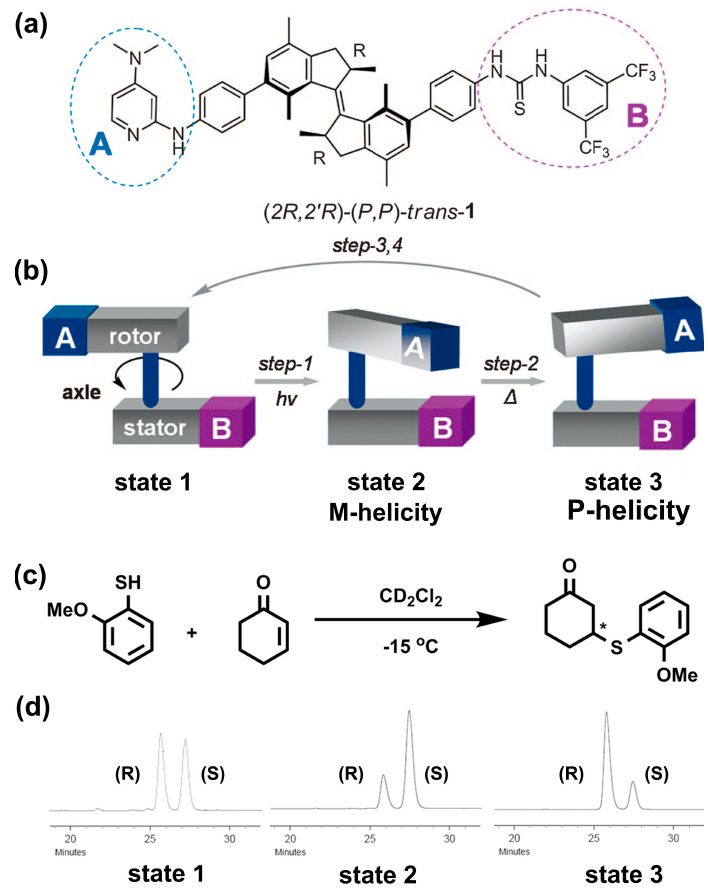
Figure 3. ( a ) Chemical structure of light-driven molecular motor; ( b ) Schematic illustration of one full rotary cycle by photo and thermally stimuli; ( c ) The catalytic reaction scheme and conditions; ( d ) HPLC traces of the reaction product utilizing catalyst in state 1 ( S / R = 49/51), state 2 ( S / R = 75/25) and state 3 ( S / R = 23/77), respectively. Reproduced from [40] with copyright permission.